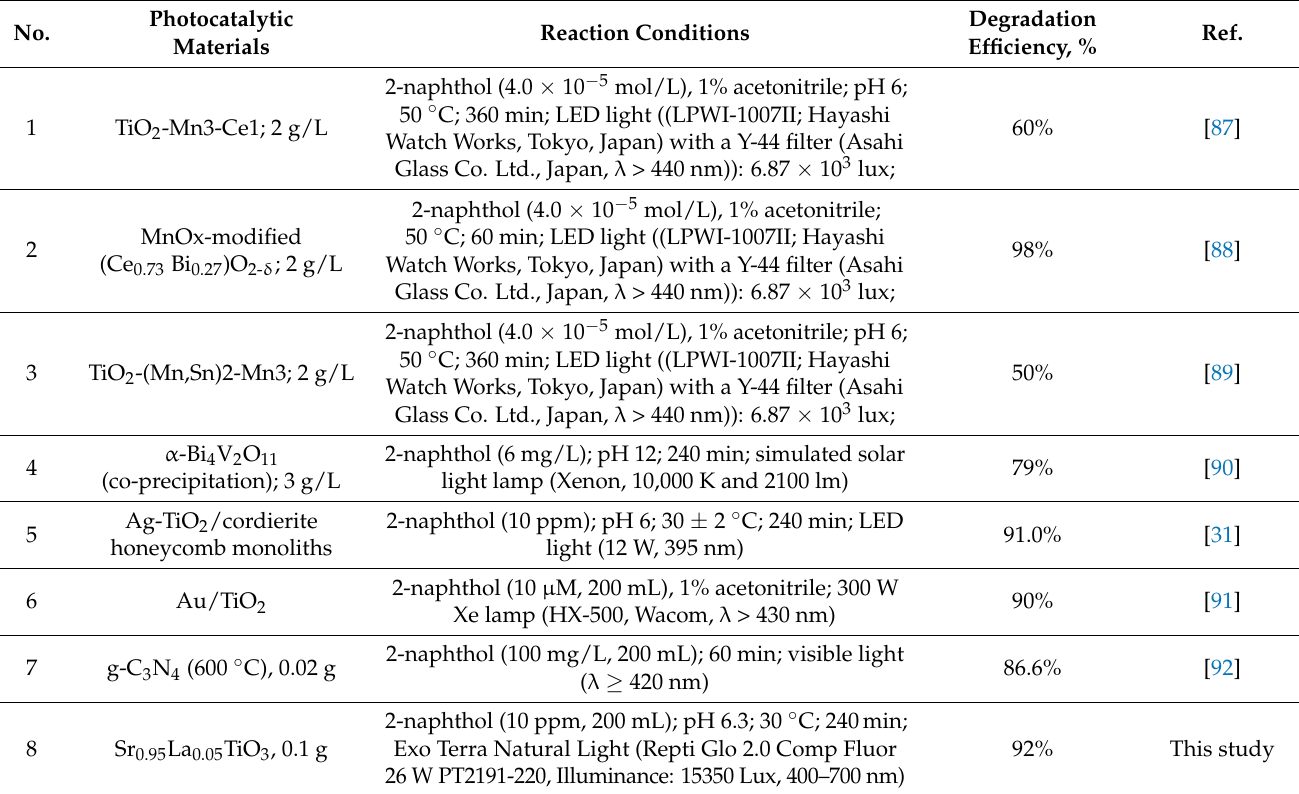
Table 5. Recent achievements of the photodegradation of